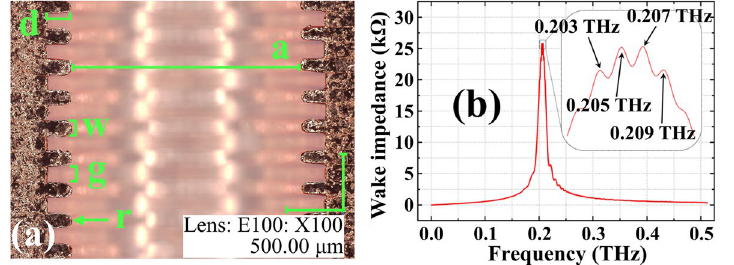
Figure 2. Fabricated corrugated structure and corresponding simulated wake impedance. ( a ) A picture of a half-cut accelerator column. Note that the structure in the picture is not the high-power-tested one. Although the design was the same, the final dimension could have difference due to the polishing process. ( b ) Longitudinal wake impedance of the optimized design. Impedance peaks are located in 0.20–0.21 THz.